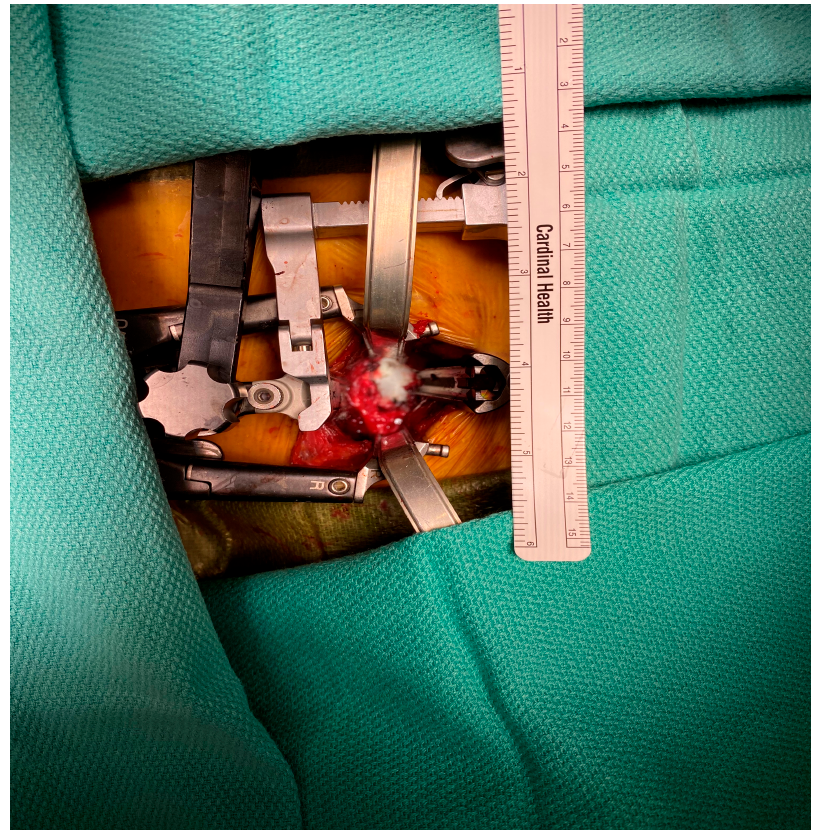
Figure 1. The small incision required by the minimally invasive retractor to allow for adequate exposure for lateral spine exposures.